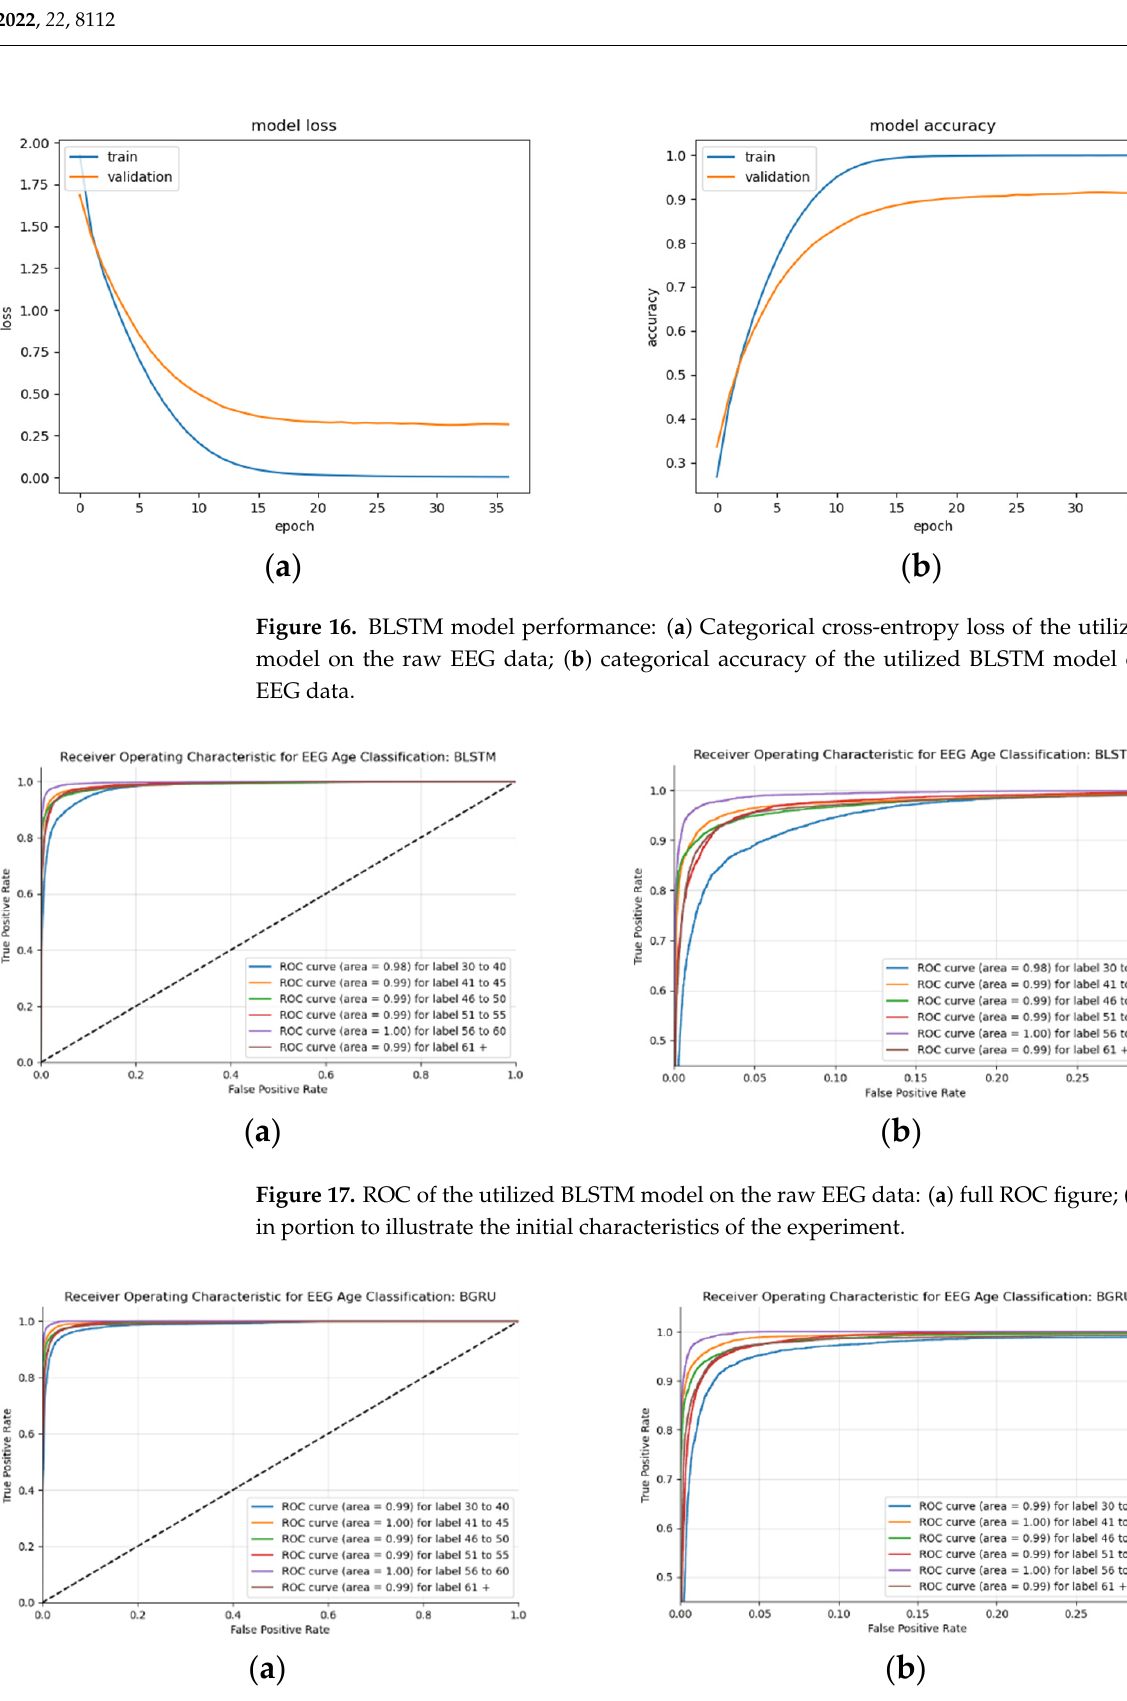
Figure 18. ROC of the utilized BGRU model on the raw EEG data: ( a ) full ROC figure; ( b ) zoomed in portion to illustrate the initial characteristics of the